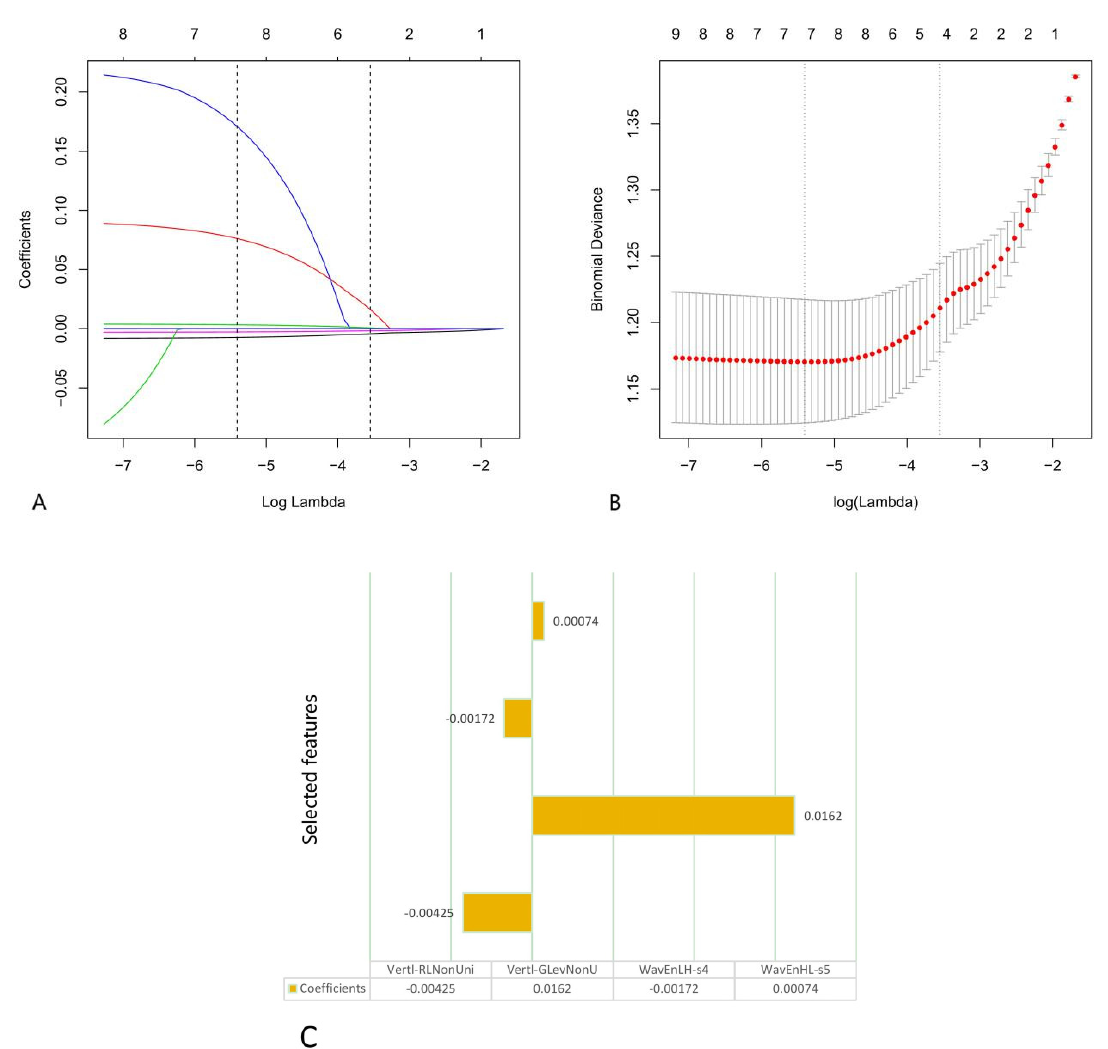
Figure 1. The second step of features selection using the least absolute shrinkage and selection operator (LASSO) logistic regression from ten features selected by the lowest probability of classification error and average correlation coefficients (POE + ACC). ( A , B ) Ten-fold cross-validation based on 1se was used to select the tuning parameter ( λ ) in the LASSO regression model. An optimal λ value of 0.0288 was selected. ( C ) The four selected features and coefficients of the Rad-score were indicated by the y -axis and x -axis, respectively.